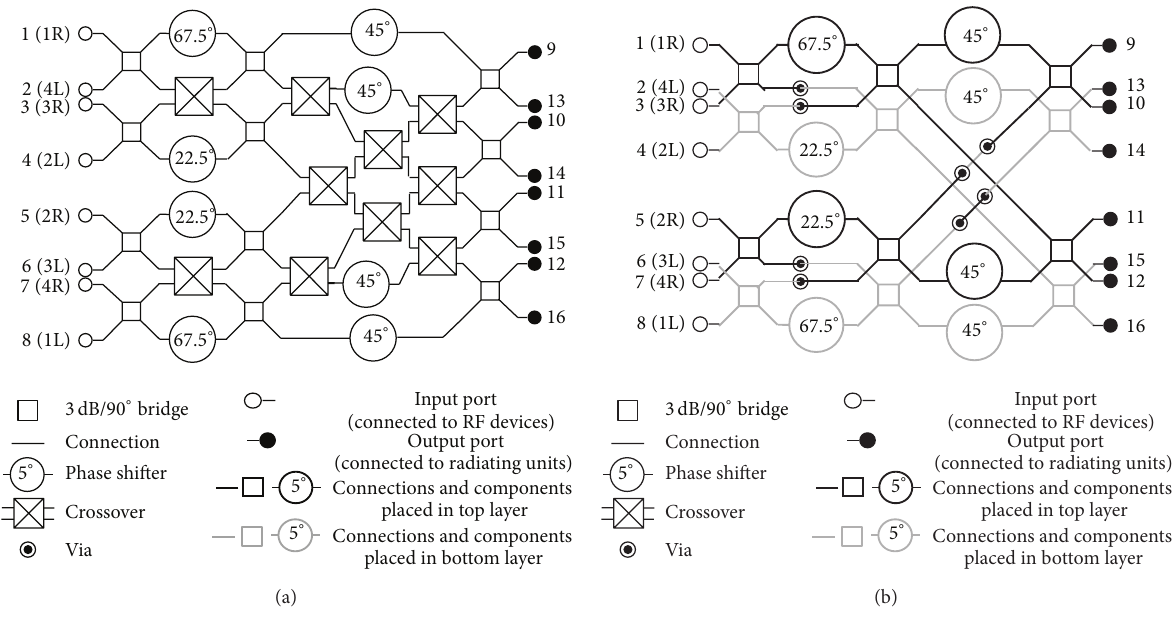
Figure 1: The schematic diagram of classic 8 × 8 Butler matrix (a) and the schematic diagram of the 8 × 8 Butler matrix based on bilayer microstrip (b).